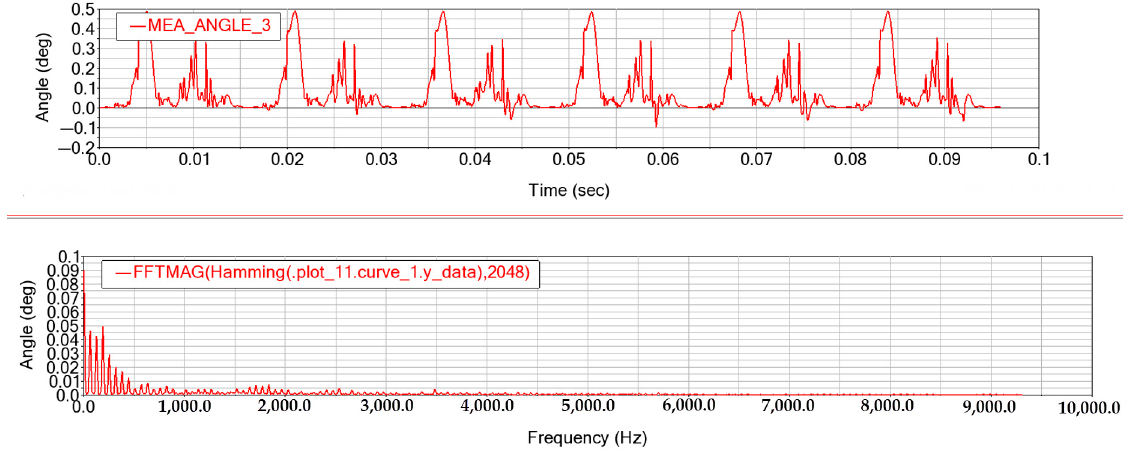
Figure 27. Free end torsional vibration at a running speed of 3800 r/min.